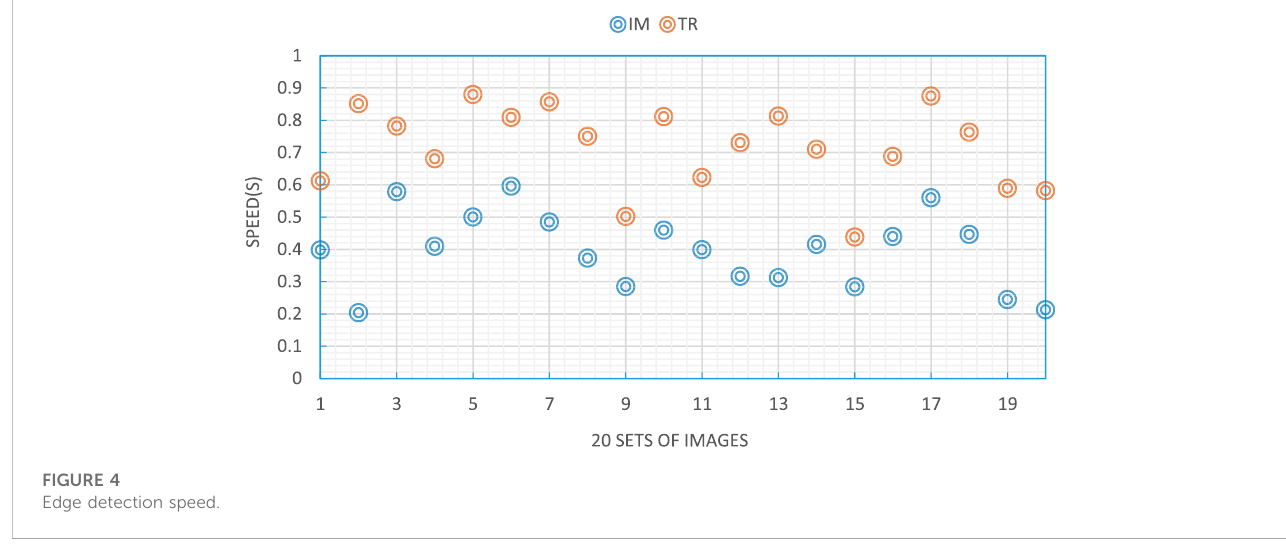
FIGURE 4 Edge detection speed.